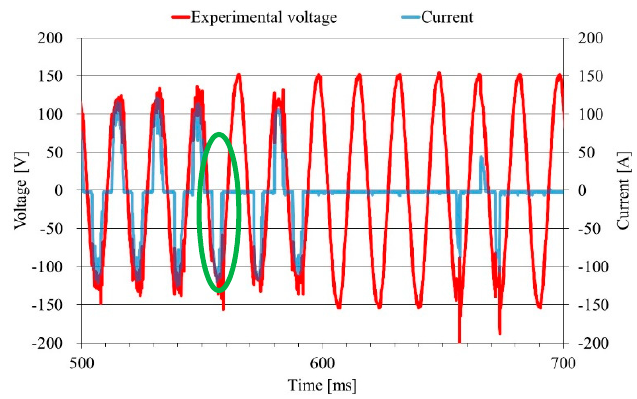
Figure 15. Sample voltage and current waveforms at a short circuit.